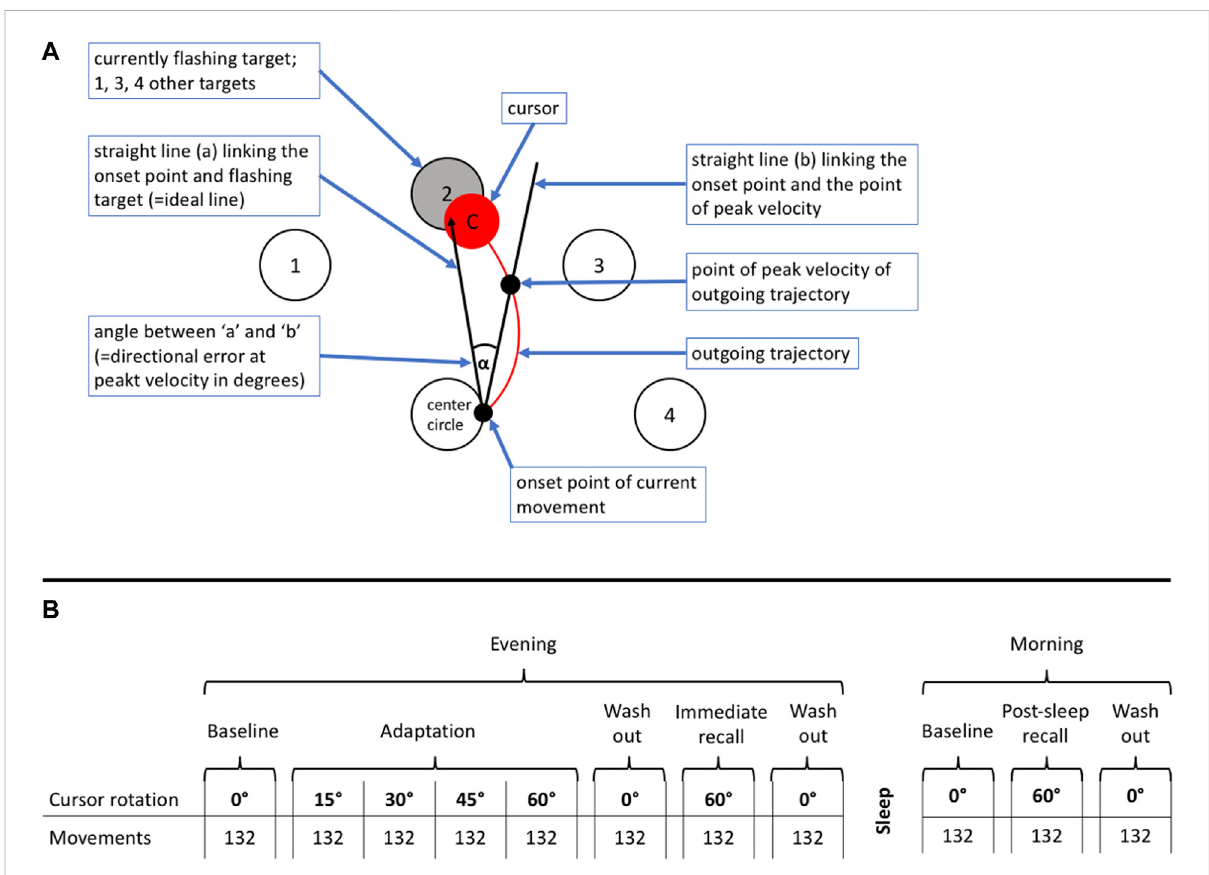
FIGURE 1 (A) Schematic representation of the computer video screen as presented to a patient during the visuomotor learning task. The patients had to operate a handheld mouse on a drawing board below an opaque shield. The position of the mouse was indicated as a cursor on a computer screen. Four different targets (1 – 4) were located in a semi-circular array around the center. Participants were instructed to move the cursor from the center circle (= starting point) to the fl ashing target and immediately back, in the most direct and fastest way possible, and in one go. The fl ashing